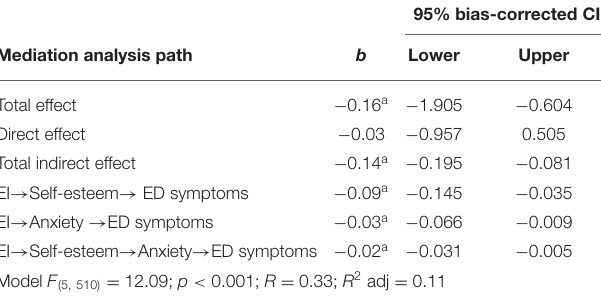
TABLE 3 | Testing the pathways of the serial mediation